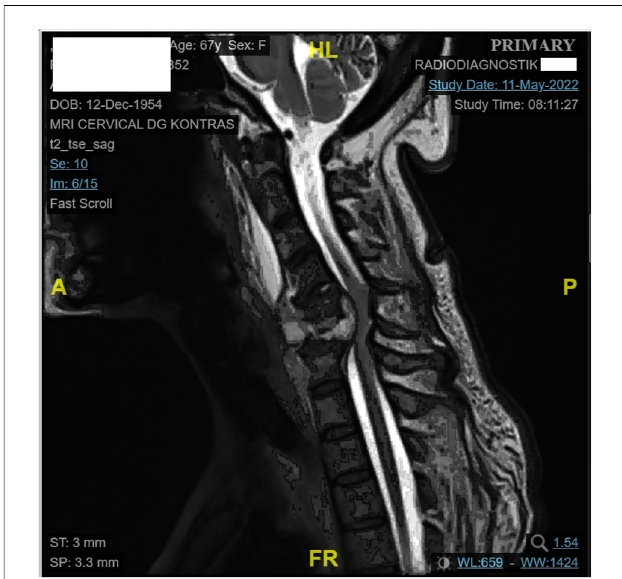
FIGURE 1 MRI of the patient. Vertebral body destruction of C5 and C6 accompanied by signs of myelopathy, suggestive paravertebral abscess measuring 1.54 x 3.50 x 1.67 cm, in fi ltrating m. long of neck bilateral, retrolisthesis of the C6 to C7 vertebral bodies posteriorly with a displacement of >50%. Supporting the diagnosis of SCI of our